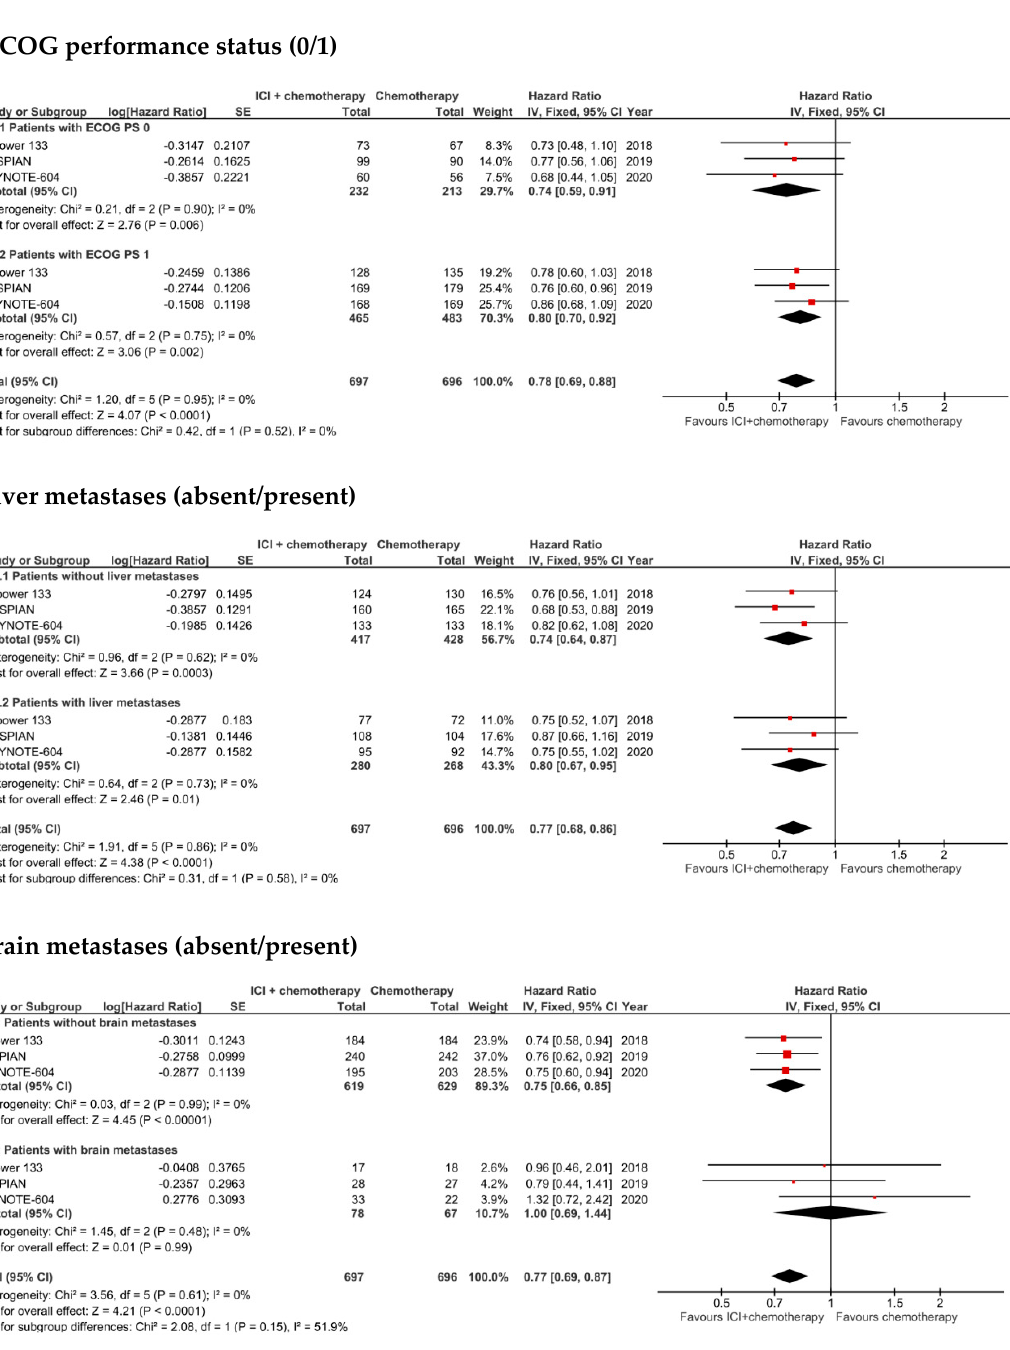
Figure 2. Overall survival. Subgroups analyses ( A – F ) for overall survival for the four clinical trials included in the meta-analysis, in the intention-to-treat populations. IV: Inverse variance; 95% CI: 95% confidence interval.